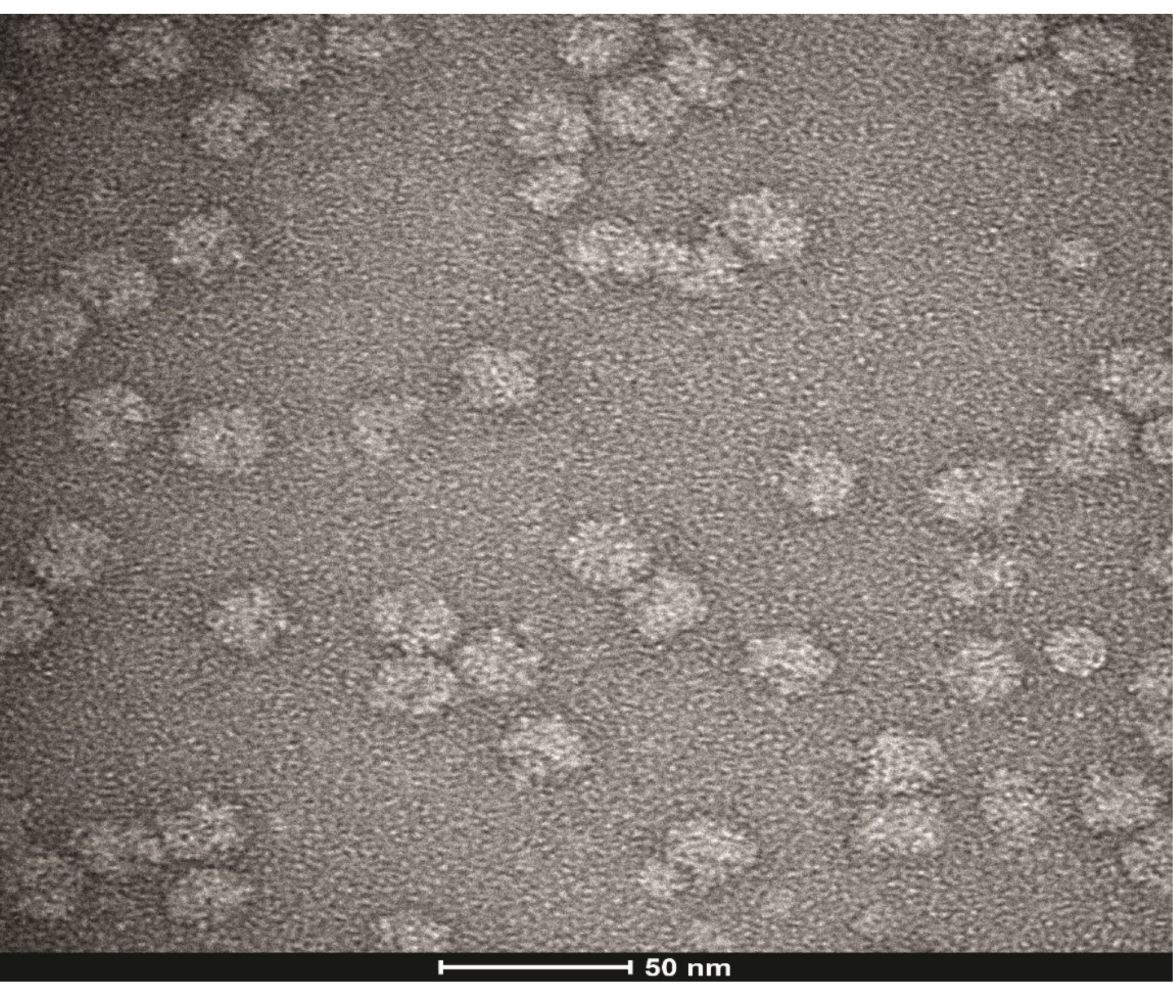
Figure 3. Purified E. coli ribosomes negatively stained with uranyl acetate on a carbon-coated grid and observed by electron microscopy with 120 kV Talos L120C TEM. The white bar below shows the relative size in nanometer. The 50S and 30S subunits can be observed in many of the